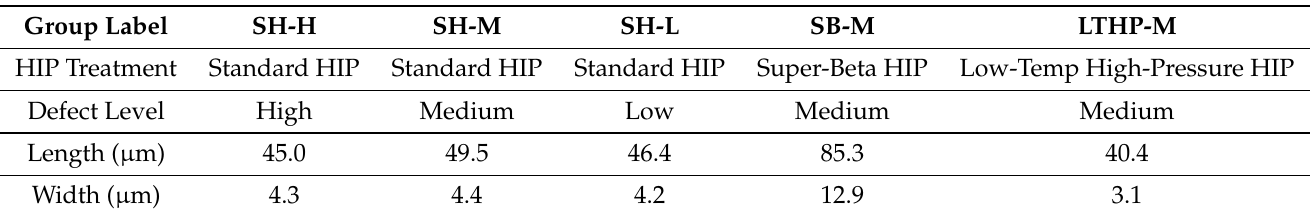
Figure 5. EBSD images showing the microstructure of specimens after HIP treatment from ( a ) a low-temperature high-pressure HIP group with high defect density (LTHP-M), ( b ) a standard HIP group with low defect density (SH-L), and ( c ) a super-beta HIP with medium defect density (SB-M). Note: both α and β phases are shown. The highest fraction of β of any group was ≤ 0.1% in the SB-M sample, as expected. Table 4. Quantified average α -lath length and width after HIP. Note: defect level refers to the relative defect density for each group quantified via CT analysis prior to